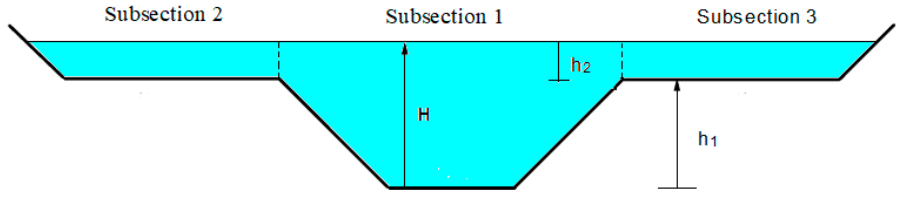
Figure 1. Division of typical compound section by vertical lines.